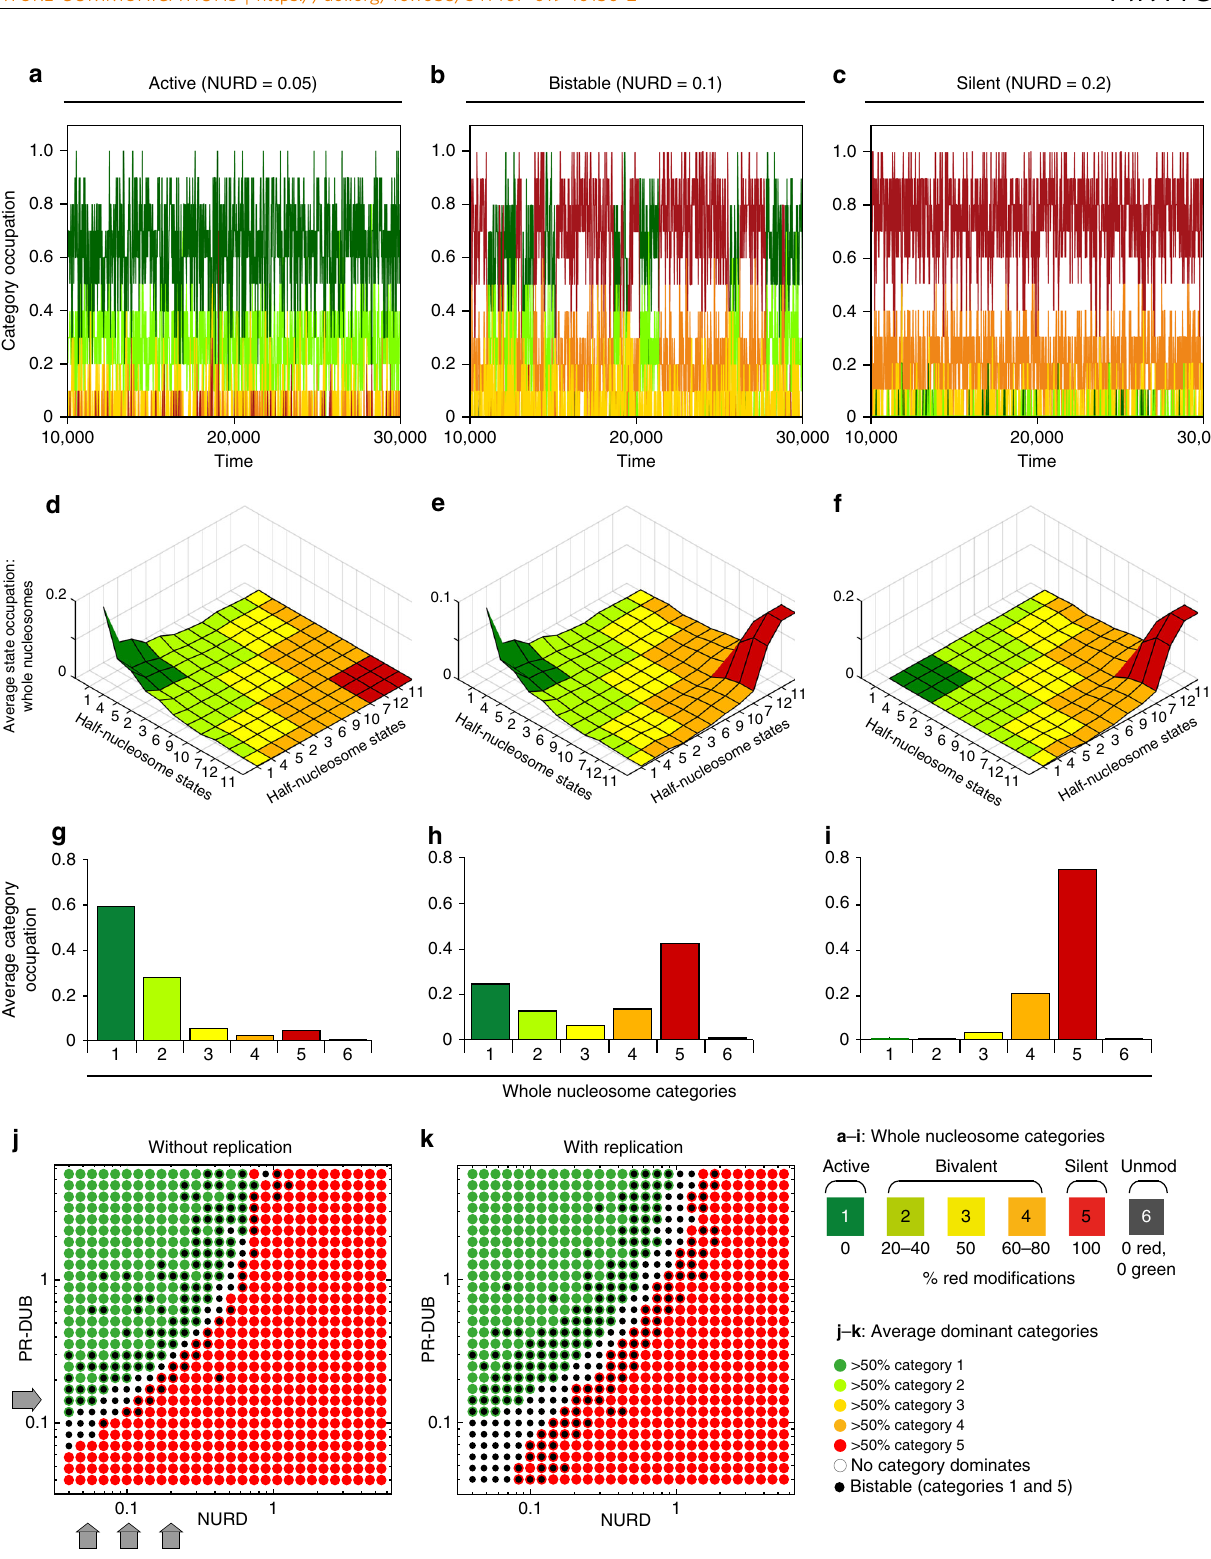
on the most stably silent states (bottom right of red zones in Fig. 3j, k, and Supplementary Fig. 3a and b). Thus in the model, suf fi cient feedbacks exist for epigenetic memory of both active and silent chromatin states under a wide range of conditions. Surprisingly however, silent states near the transition zone were weakened by replication, with a correspondingly wider parameter regime for bistable transitions between the extreme states (Fig.